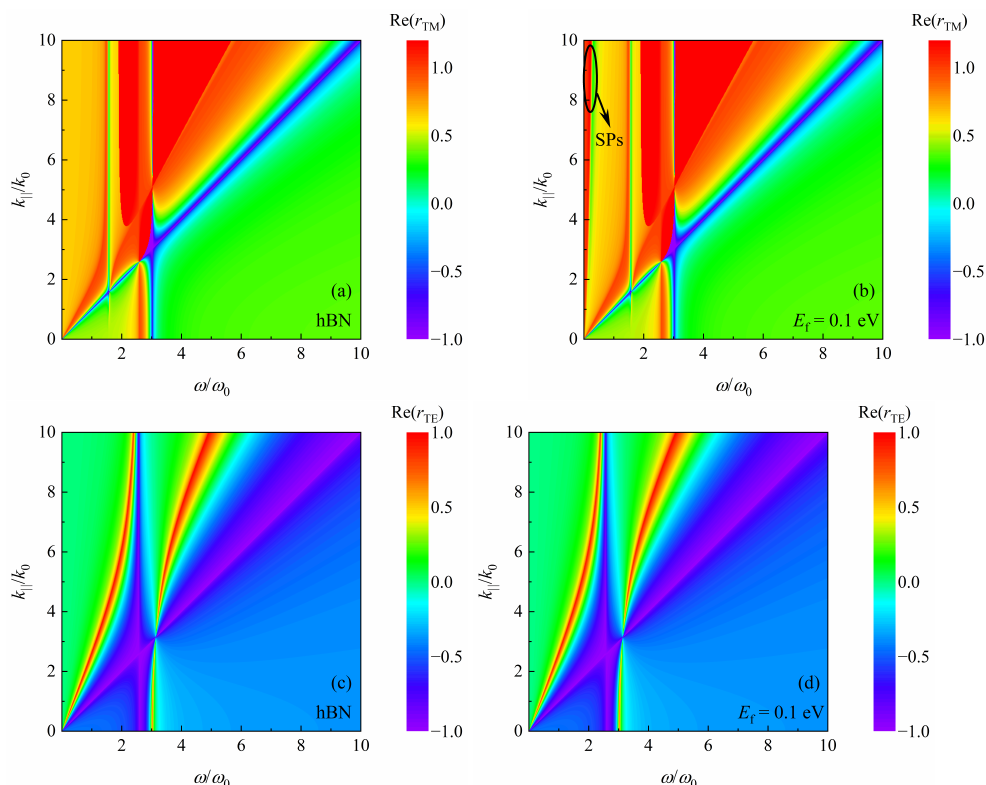
Figure 4. Re ( r TM ) or Re ( r TE ) as function of ω and k || . ( a ) Re ( r TM ) of hBN. ( b ) Re ( r TM ) of graphene- covered hBN with Fermi level E f = 0.1 eV. ( c ) Re ( r TE ) of hBN. ( d ) Re ( r TE ) of graphene-covered hBN with Fermi level E f = 0.1